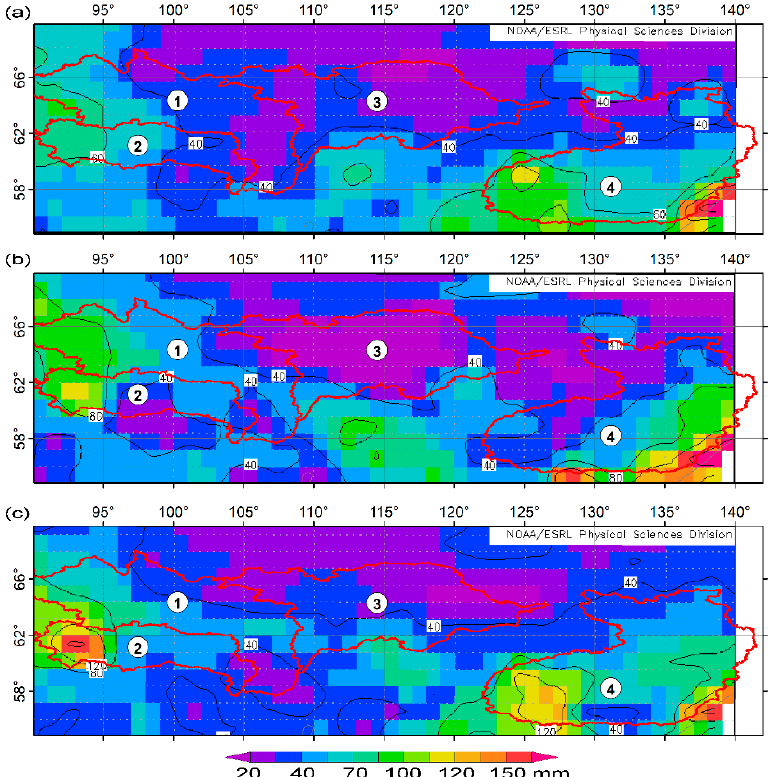
Figure 5. The reanalysis data [32] of the precipitation for September. ( a ) The long-term mean, ( b ) 2012, and ( c ) 2013. The river basins are 1—Lower Tunguska, 2—Podkamennaya Tunguska, 3—Viluy, and 4—Aldan.